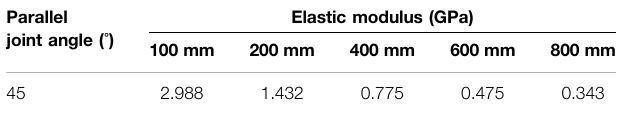
TABLE 6 | Elastic modulus of different rock sizes at joint angles of 45 ° . Parallel joint angle ( ° )